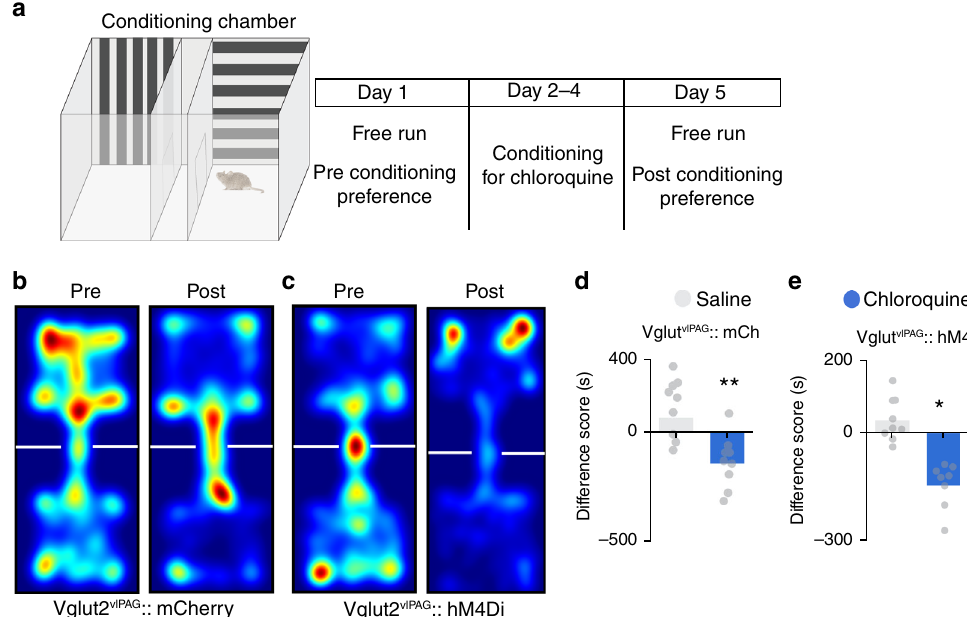
Fig. 8 vlPAG glutamatergic neurons do not mediate aversive component of itch. a Schematic of conditioned place aversion experimental design indicating saline-paired and chloroquine-paired chambers and the timing of each session in Vglut2::hM4Di and Vglut2::mCherry mice. b Representative heat map showing location of a control mouse injected with mCherry in the vlPAG of Vglut2 Cre mice, pre-chloroquine and post-chloroquine conditioning. c Representative heat map showing location of a mouse injected with hM4Di in the vlPAG of Vglut2 Cre mice, pre-chloroquine and post-chloroquine conditioning. d CNO (5 mg/kg, i.p) administration in vlPAG::mCherry mice did not have any effect on the time spent in the chloroquine paired chamber compared to saline paired chamber ( N = 9, t test, t = 3.435, df = 16, ** P = 0.0034). e Inhibition of Vglut2::hM4Di neurons in the vlPAG with CNO (5 mg/